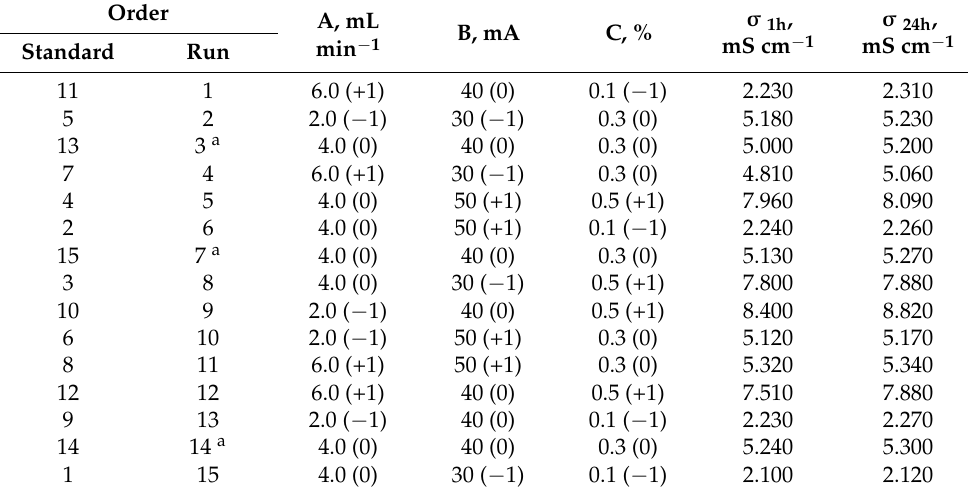
Table 1. Box-Behnken response surface design with actual and (coded) values of operating param- eters related to application of a continuous-flow FLC-dc-APGD reaction discharge system for the production of NH 4 NO 3 -based PALs having certain electrical conductivity measured after 1 ( σ 1h ) and 24 h ( σ 24h ).